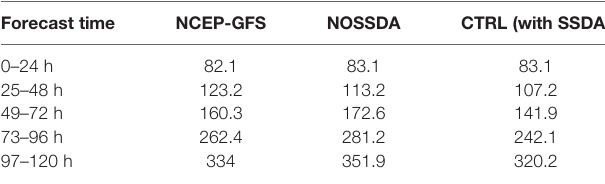
TABLE 2 | The mean TC forecast track errors (unit: km) for the 8 tropical cyclones in the North Indian Ocean (NIO) during 2018 – 2020. Forecast